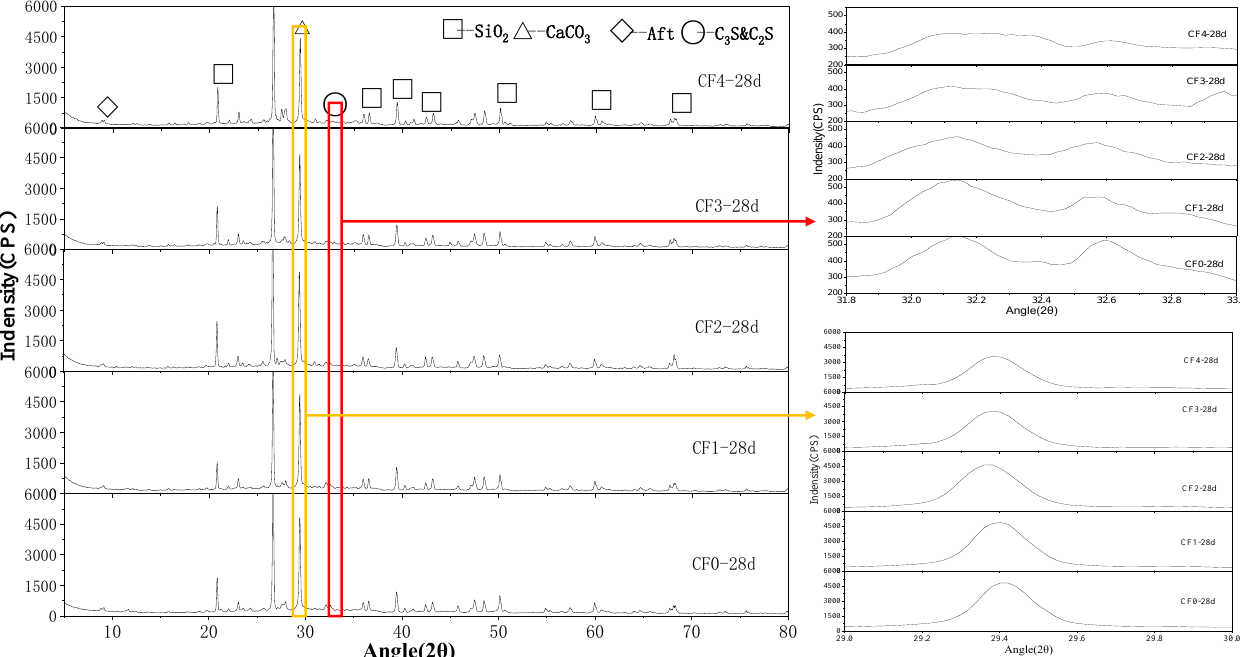
Figure 8. X-ray diffraction pattern analysis results of fly-ash-modified CSM with 100% RMA and a partial enlarged view of characteristic peaks at an age of 28 d.